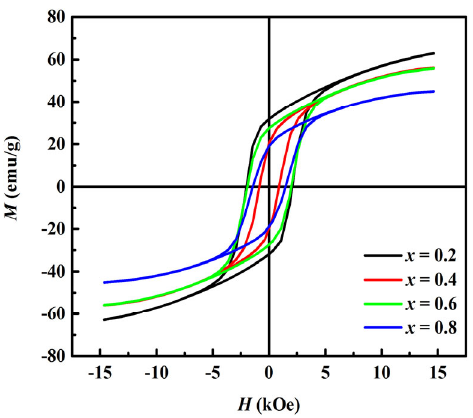
Fig. 3 Magnetic hysteresis loops ( M – H ) of samples at room